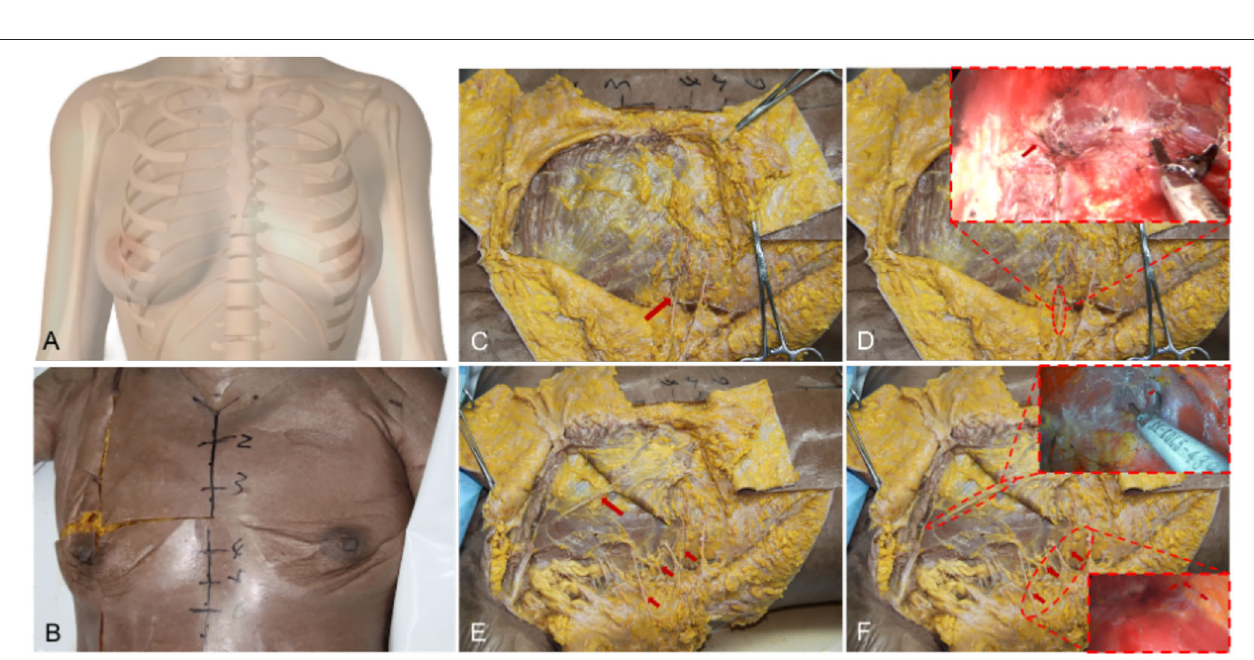
FIGURE 7 | General anatomy of the breast and the vessels anatomy of the lateral and upper pocket. (A) A schematic diagram shows the adult female breasts. (B) Breast general anatomy showed the approximate location of the adult female breasts. (C) Arrow indicates the anterior cutaneous branch of the fourth intercostal nerve. (D) The anterior cutaneous branch of the fourth intercostal nerve needs to be carefully protected combined with an endoscope. (E) Arrows indicate a deep blood vessel from the pectoralis minor to the pectoralis major in the upper pocket and a set of intercostal nerves and their accompanying blood in the upper pocket. (F) Vascular anatomy of lateral and upper pocket combined with an